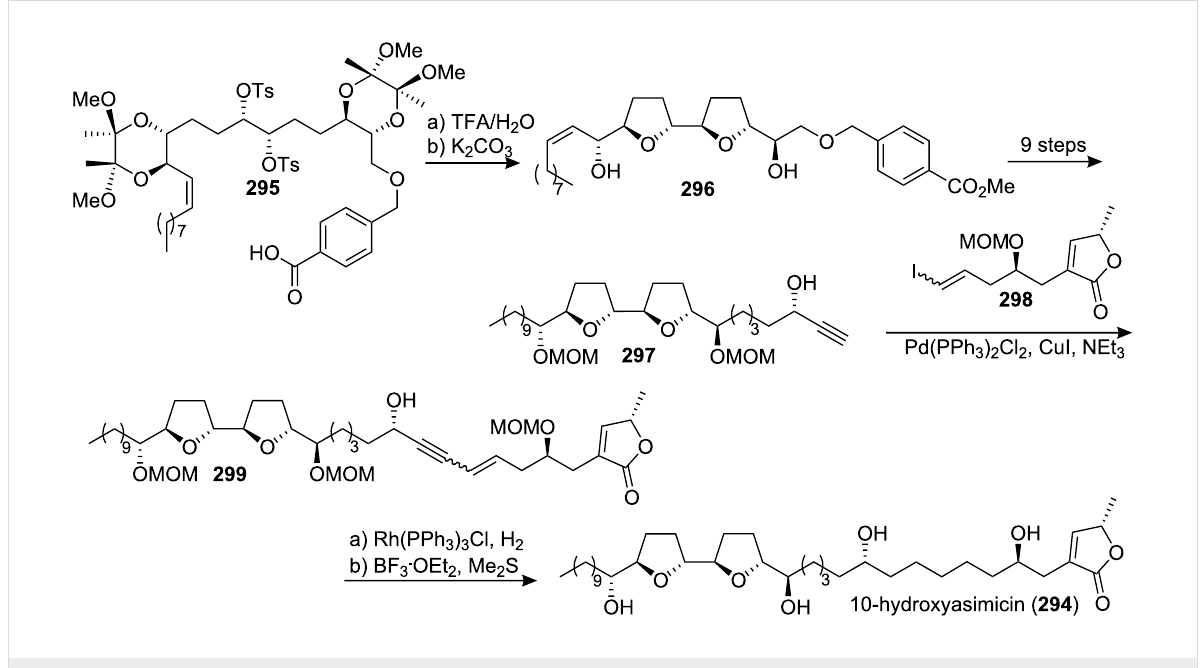
Scheme 40: Total synthesis of 10-hydroxyasimicin by Ley’s